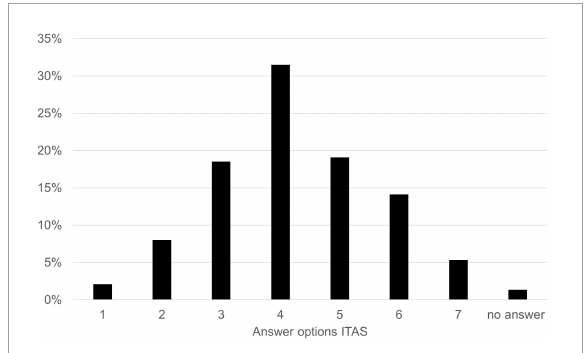
FIGURE4 Percentage distribution of sample 1 responses given across the 7-level